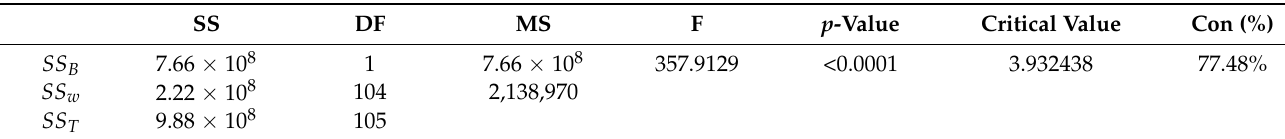
Table 8. ANOVA results for the spindle speed.